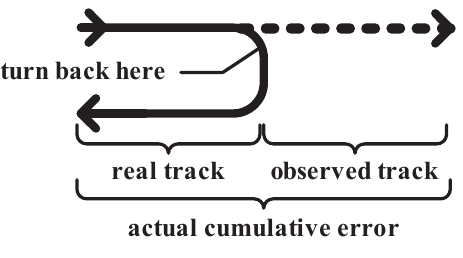
Figure 11. The scenario with the maximum error.